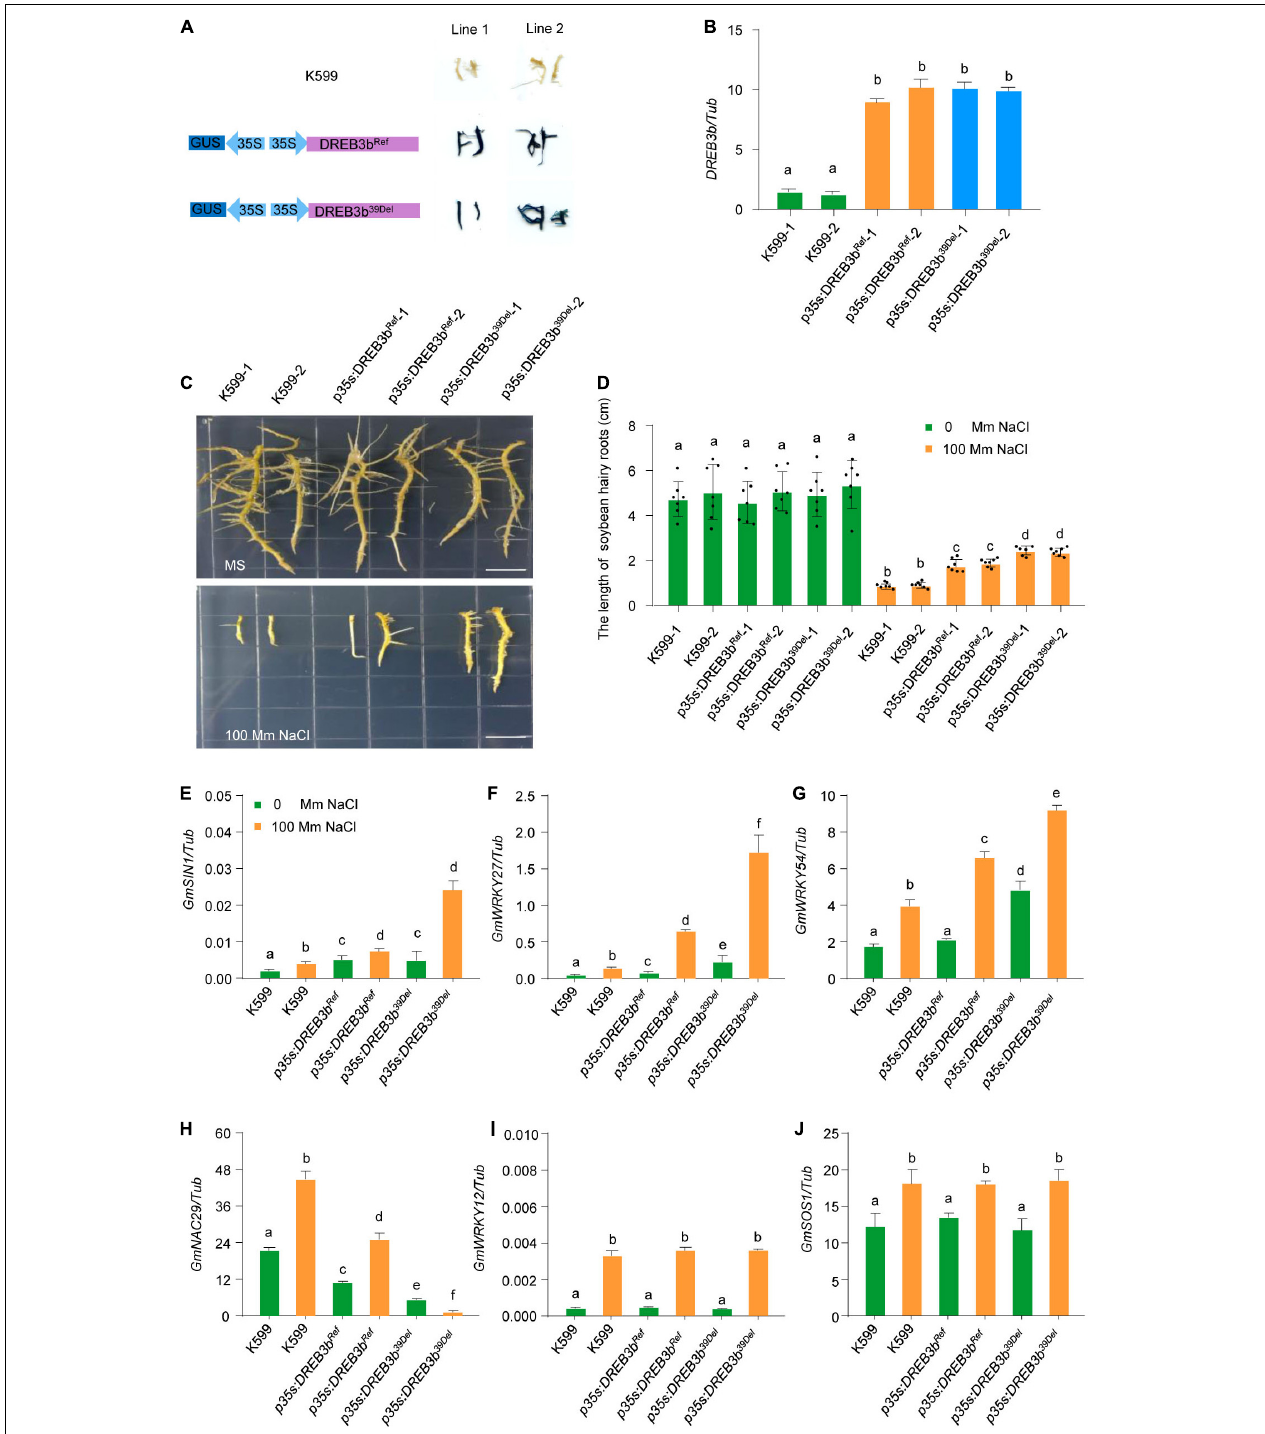
FIGURE 6 | DREB3b 39 Del improves salt tolerance more than DREB3b Ref in transgenic soybean hairy roots. (A) Schematic diagram of overexpression vector and GUS staining of overexpressing DREB3b 39 Ref and DREB3b 39 Del in soybean hairy roots. (B) The transcript levels of DREB3b in W82 and two independent DREB3b 39 Ref and DREB3b 39 Del transgenic lines grown under normal growth conditions. (C,D) Phenotype of the transgenic lines overexpressing DREB3b 39 Ref and DREB3b 39 Del with or without 100 mM NaCl treatment. The lengths of soybean hairy roots were obtained from at least seven roots. (E–J) DREB3b regulates the expression of salt stress-tolerant gene in soybean with or without 100 mM NaCl treatment. Experiment was performed using three biological replicates. The same lowercase letters above the histogram bars denote non-significant differences across the two panels ( P > 0.05). One-way ANOVA was used to generate the P